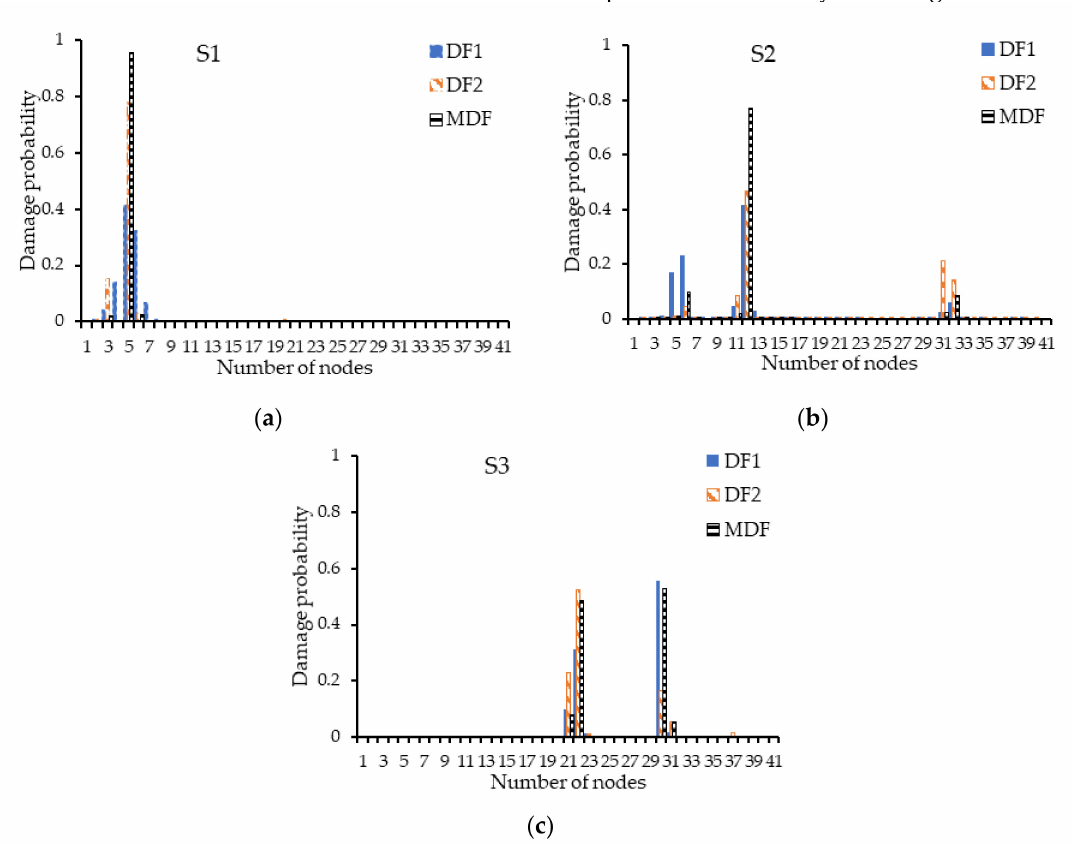
Figure 9. The results of two-stage fusion. ( a ) damage condition S1; ( b ) damage condition S2; ( c ) damage condition